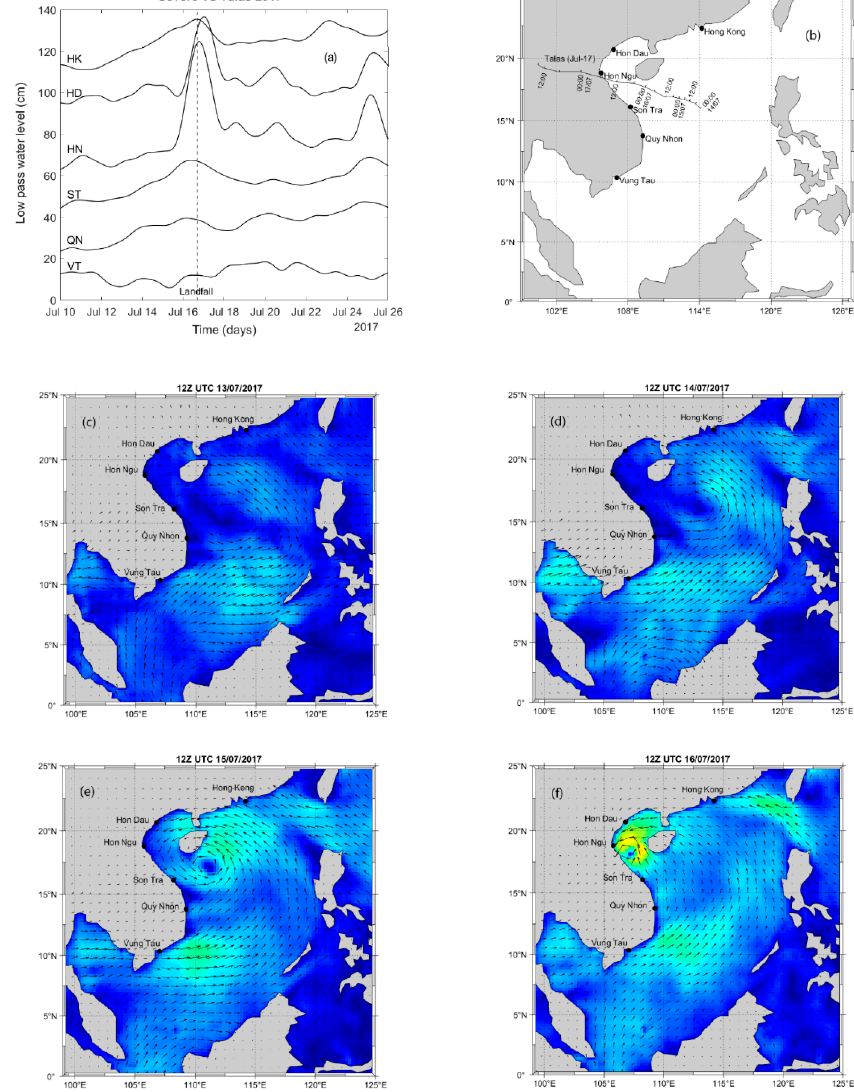
Figure 10. ( a ) Time series of observed, residual and low-pass filtered water levels during Severe Tropical Storm Talas (11–27 July 2017) at all stations; ( b ) the track of Severe Tropical Storm Talas; and ( c – f )—wind field at 12Z UTC from 13 to 16 July 2013. Key: HK: Hong Kong; HD: Hon Dau; HN: Hon Ngu; ST: Son Tra, QN: Quy Nhon; VT: Vung Tau. The wind speed colour scale is given on Figure 9.